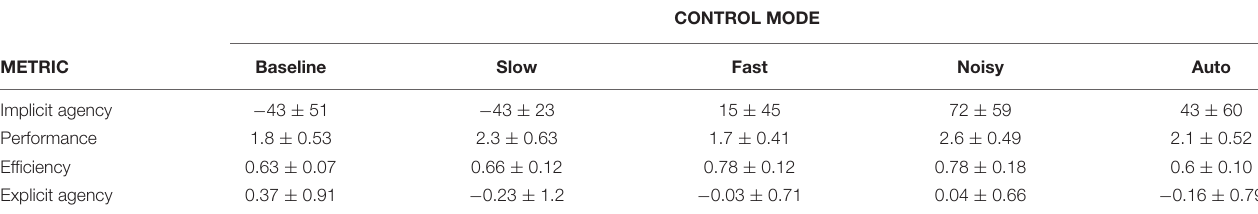
TABLE 5 | Mean shifts from rigid to compliant surface for implicit agency ( msec ), performance ( N − 1 ), efficiency ( sec 2 /N 2 ), and explicit agency ( Likert ).